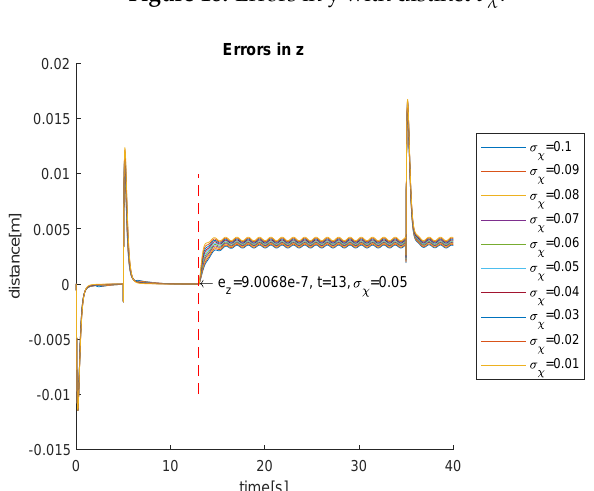
Figure 18. Errors in y with distinct σ χ .